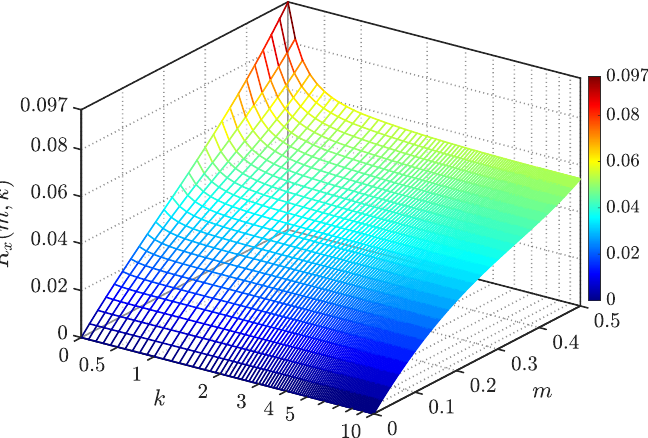
Figure 8. The normalized RMS value of phase switching current ripple as a modulating index m and k factor function.